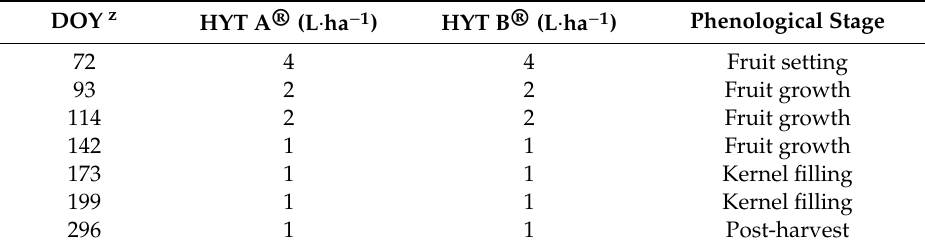
Table 2. Applications of HYT products along the irrigation period. Table 2 . Applications of HYT products along the irrigation period.